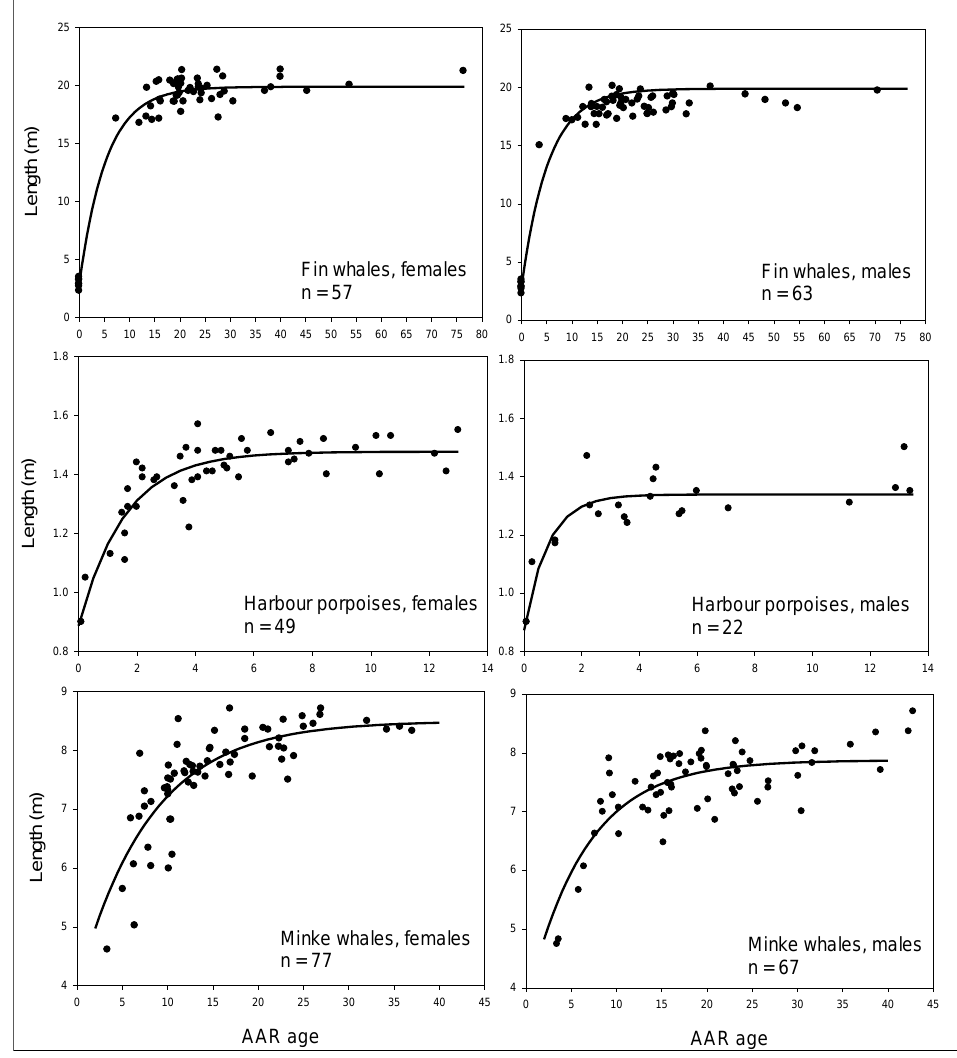
Fig. 3. Growth in female and male fin- and minke whales and harbour porpoise for AAR age. The line is mean asymptotic growth in length